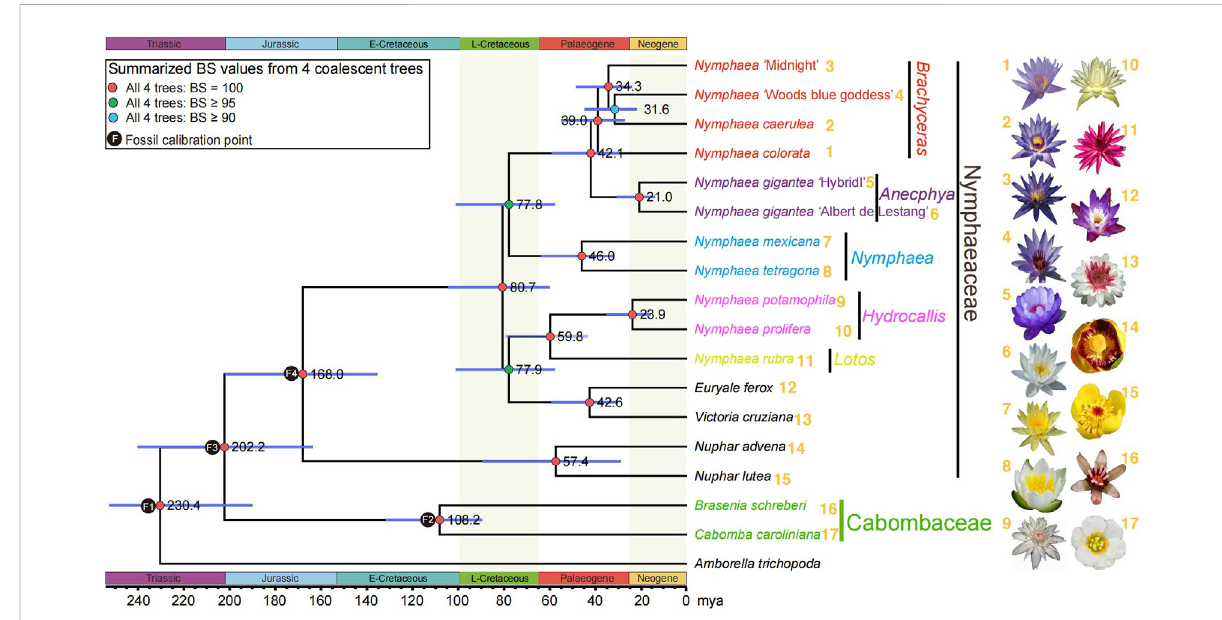
FIGURE 3 A summarized Nymphaeaceae phylogeny from four coalescent trees with corresponding bootstrap values mentioned on the left of nodes and divergence times inferred by treePL. Red circles indicate maximum (100%) bootstrap support in all four analyses. Green circles indicate at least 95% bootstrap supportinallfour coalescence analyses from1,141,942, 882, and686genesets. Cyancirclesindicateatleast90%bootstrapsupport inall four analyses. The right side of the species name shows the fl owers of the 20 sampled water lilies from our previous study (Zhang et al.,